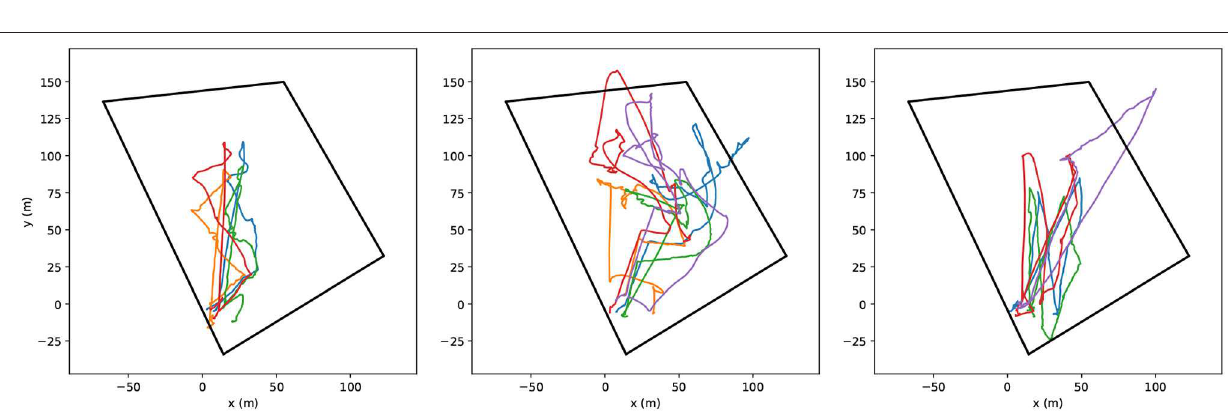
large packet drop rate and to scale well. To test the concept